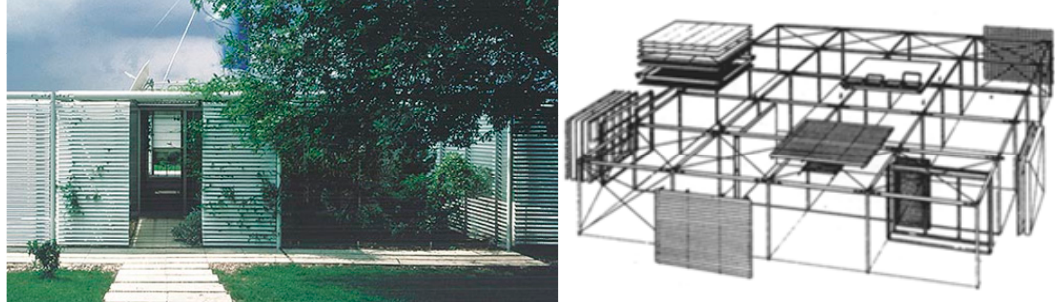
Figure 6. Michael and Patty Hopkins House, 1975–1976 [12]. Figure 7. Yacht house by Richard Horden, New Forest, England, 1984 [13].